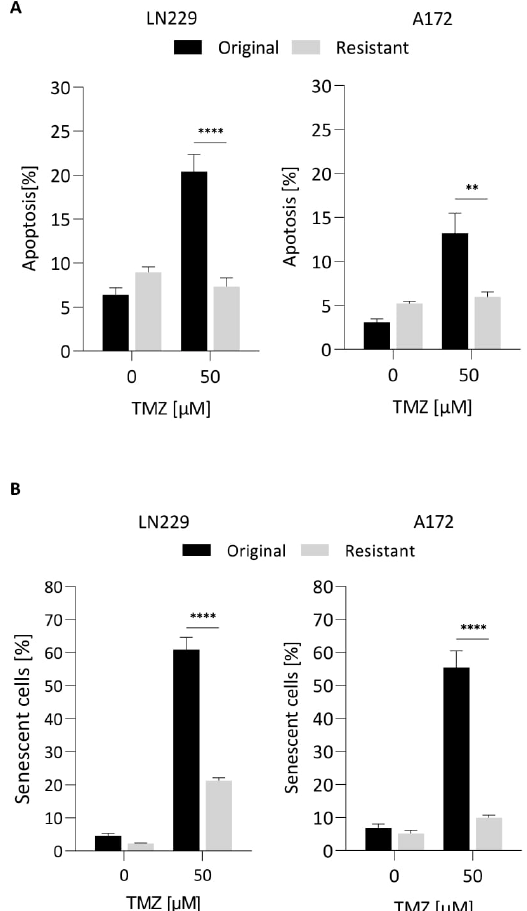
Figure 7. Repeated TMZ treatment leads to TMZ resistance of LN229 and A172 cells. LN229 and A172 cells were repeatedly treated with 50 µM TMZ. Surviving cells were reseeded and treated with 50 µM TMZ; apoptosis ( A ) and CSEN ( B ) were measured 5 and 10 days later, respectively. TMZ resistance is indicated by a lower induction of apoptosis and CSEN. ** p < 0.01, **** p < 0.0001.